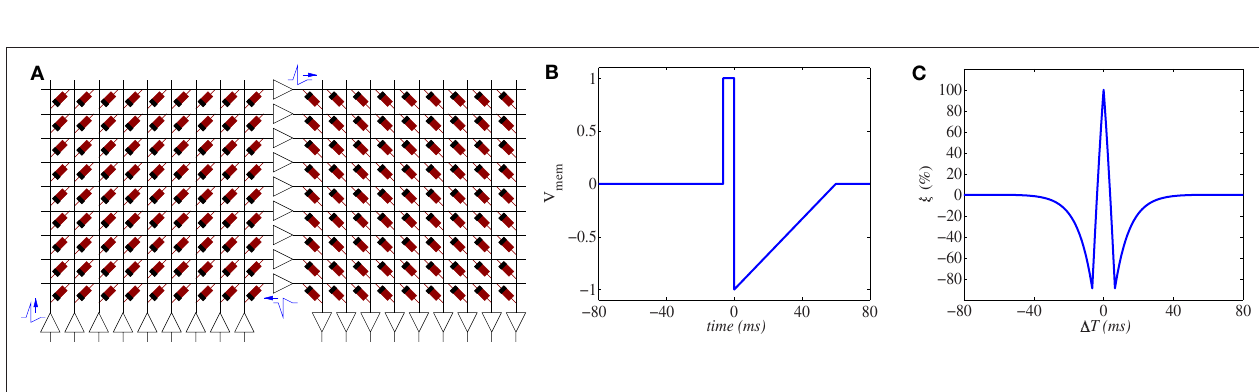
Figure 15 | Arrangement where neurons send back the inverted spike sent forward. (A) Feed forward Crossbar Example, (B) Spike shapes used, (C) and resulting STDP resistance update